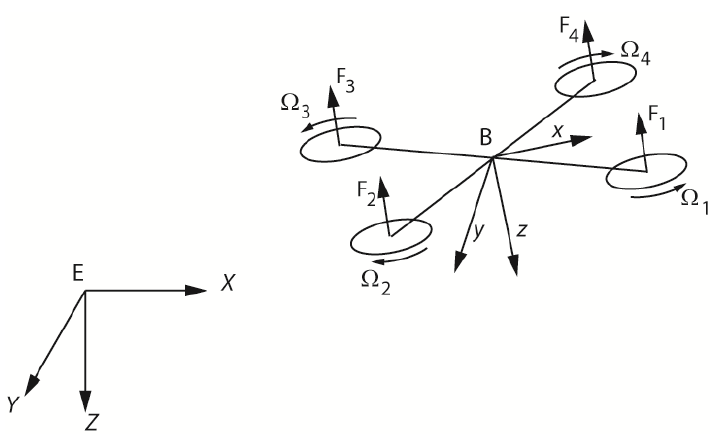
Figure 1. Configuration of the quadrotor. E ( X,Y,Z )—Earth frame; B ( x,y,z )—body fixed frame; Ω i —rotor angular velocity; F i —rotor lift